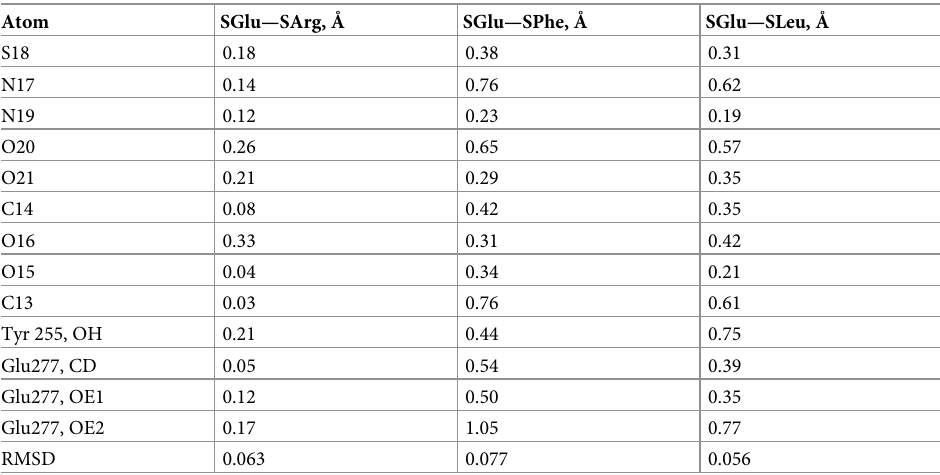
Table 2. Distances between Glu277, Tyr255 residues and N-sulfamoyl ligands atoms in superimposed CPT+SGlu and CPT+SArg, CPT+SPhe, CPT+SLeu